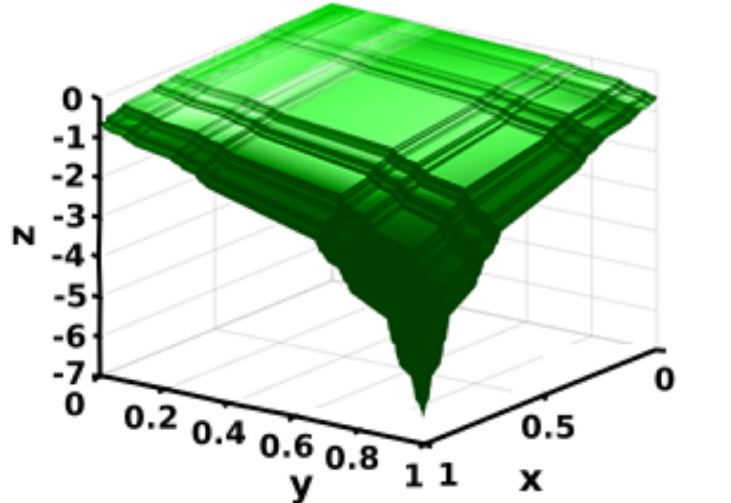
Figure 4. The v component (Equation (27)) is the fluid velocity in the fractal space for the function ( x ) + γ S α ( y )) for which α = 0.63, β = 1, γ = 1, A = 1, B = 1, c = f = exp ( β S α F F